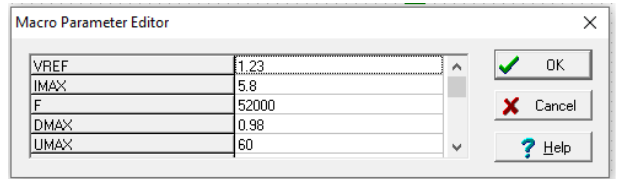
Figure 11. Universal model parameters according to the LM2576HV datasheet. The real measurement was performed with a Tektronix DPO7354 oscilloscope, and the currents were measured using Tektronix TCP0030 current probes. The measuring laboratory [27] is shown in Figure 12.